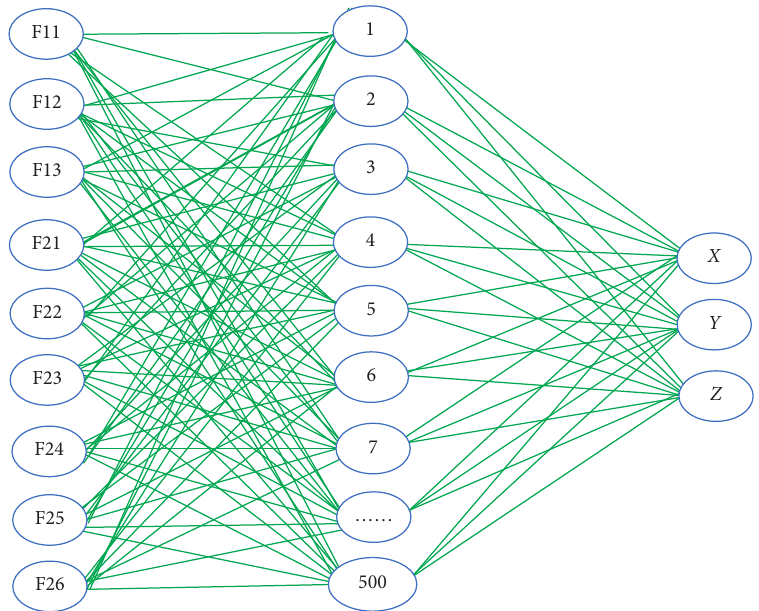
Figure 7: The DNN with the number of neurons which produces the smallest